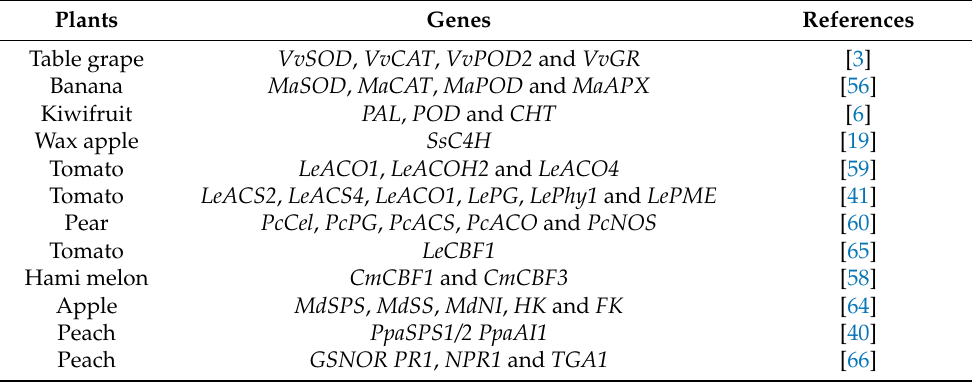
Table 2. Overview of the genes regulated by NO during the postharvest storage of fruits. Plants